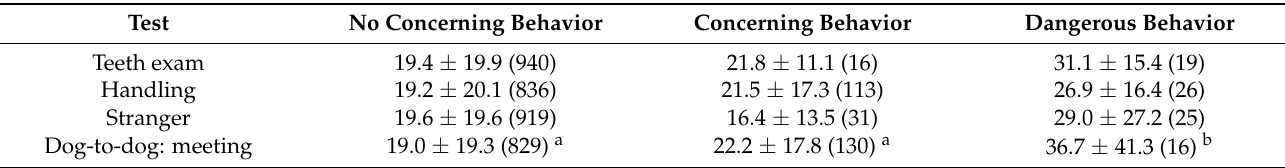
Table 4. Length of stay (mean ± SD , in days) for dogs in relation to behavior shown during tests or subtests on the behavioral evaluation at the shelter. Number of dogs shown in parentheses. Within rows, values with different superscript letters are significantly